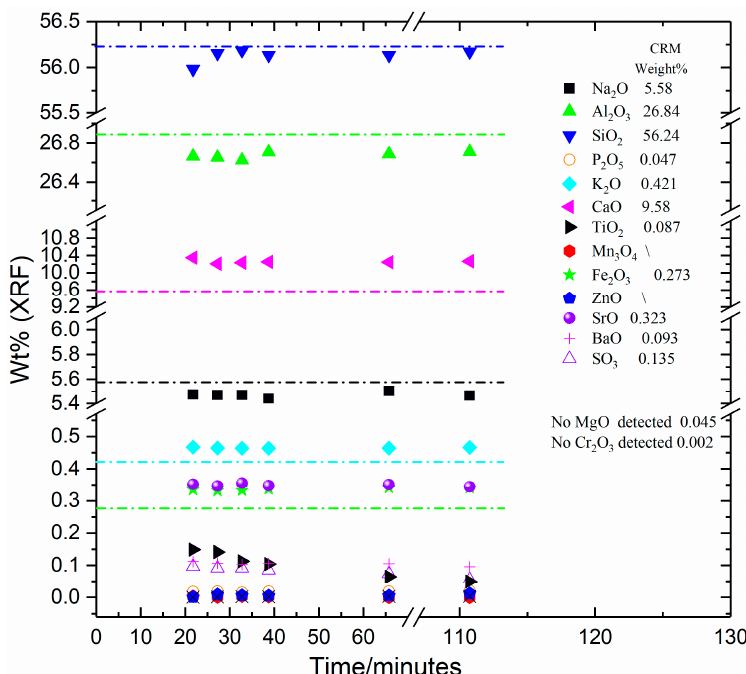
Figure 1. XRF OXI results for Certified Reference Material (CRM)-529 [41] (Anorthic Feldspar) as a function of total process time. Error bars are smaller than the data markers. Horizontal dotted lines indicate the certified composition of CRM-529. Analysed TiO 2 content includes contribution from I L β 1,2,3 lines.